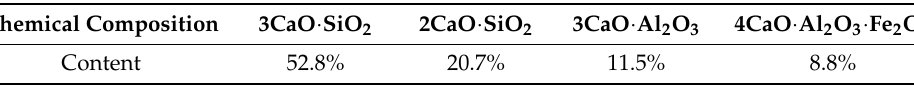
Table 1. Chemical composition of Portland cement.